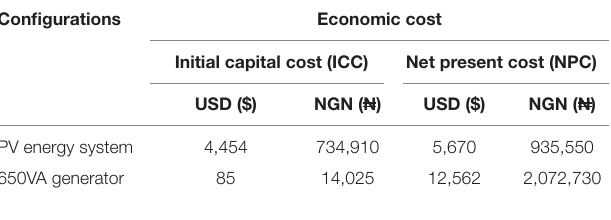
TaBle 6 | simulation results of economic